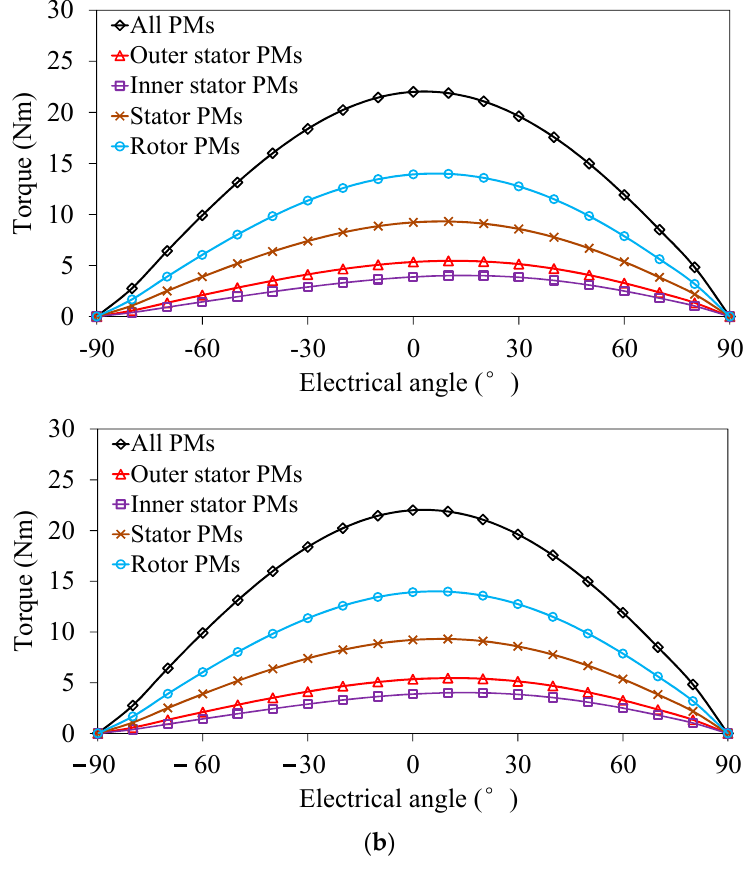
Figure 13. Torque-current angle characteristics. ( a ) Torque due to primary windings and secondary windings respectively; ( b ) total torque of two windings.